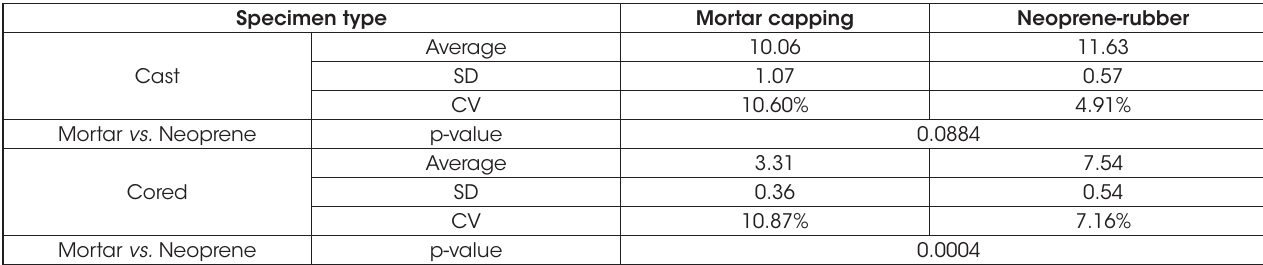
Mortar vs. Neoprene